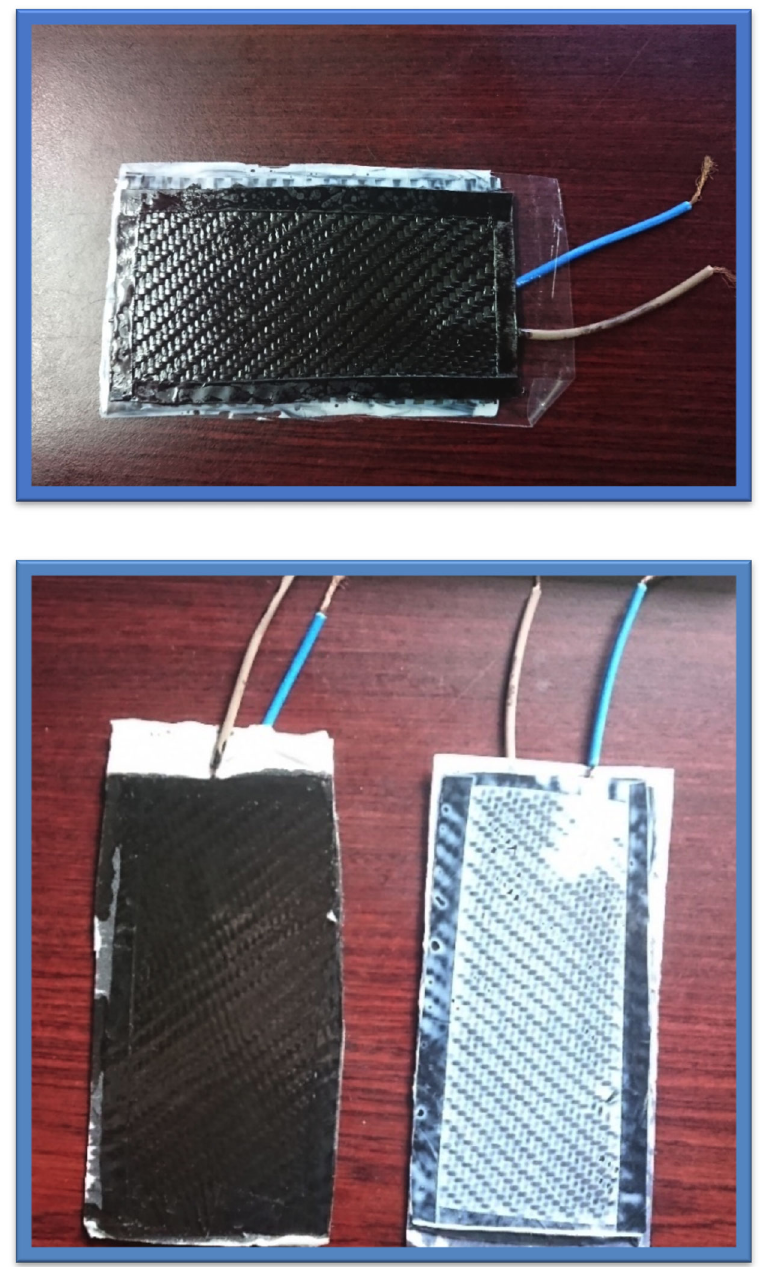
Figure 21. Organic solar cell with the composition of ZnO/CuO:AC. The performance investigations of the OSSC both in charging and discharging modes were conducted at the time for the maximum values of state of charge (SoC)(t), W/kg, and energy density, W/A · h. Figure 22 shows the SoC(t) and state of discharge (SoD)(t) of the OSSC for different percentages of activated carbon (AC). It was noted that the wt% of ZnO for the P-type was kept constant but only the wt% of AC was changed. The result showed the difference both in charging and discharging for 6–20% of the AC. The higher percentage of AC particles increased the surface area and created more pores as well as utilising the PVDF polymer chains to wrap the CFs. However, the excessive percentage of AC